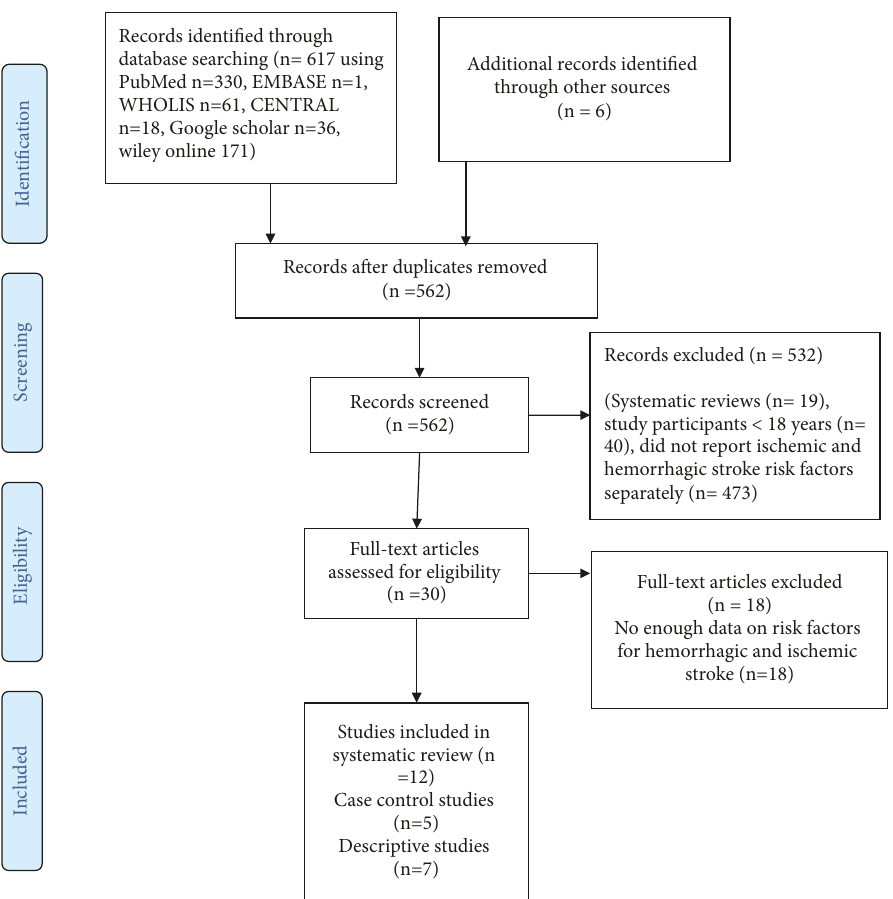
Figure 1: PRISMA flow diagram for the systematic review of risk factors for hemorrhagic and ischemic stroke in sub-Saharan Africa. Footnotes . The flow diagram template was adopted from the PRISMA statement